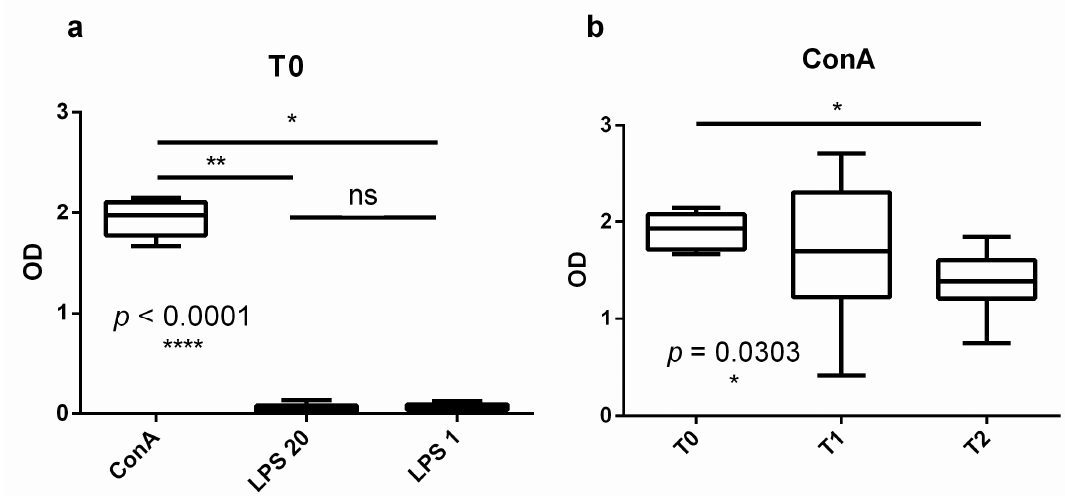
Figure 1. In vitro proliferation of bovine PBMCs at different time points. Bovine PBMCs isolated at three different time points were in vitro stimulated with ConA or LPS (20 µ g/mL and 1 µ g/mL). Cell proliferation was determined by an ELISA assay after BrDU incorporation. ( a ) Stimulation of PBMCs at 15 days before calving (T0); similar results were obtained at 7 and 21 days post-calving (T1 and T2, respectively). ( b ) Blastogenic response of PBMCs to ConA at three different time points. * p < 0.05; ** p < 0.01; **** p < 0.0001.